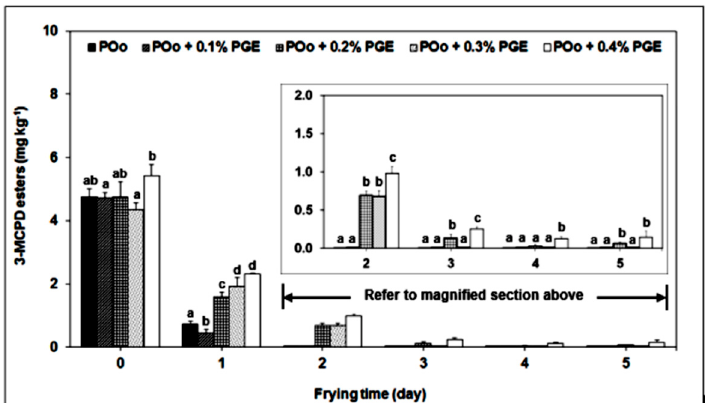
Figure 2. Degradation of 3-chloropropane-1,2-diol (3-MCPD) esters in palm olein (POo) added with polyglycerol fatty acid esters (PGE) during repeated frying. The 3-MCPD esters for frying times between day 2 and day 5 can be referred to in the magnified section to improve clarity. One-way analysis of variance (ANOVA) was used to indicate the significant di ff erence between the control experiment (POo without PGE) and each frying interval ( p < 0.05), as shown by di ff erent lowercase letters